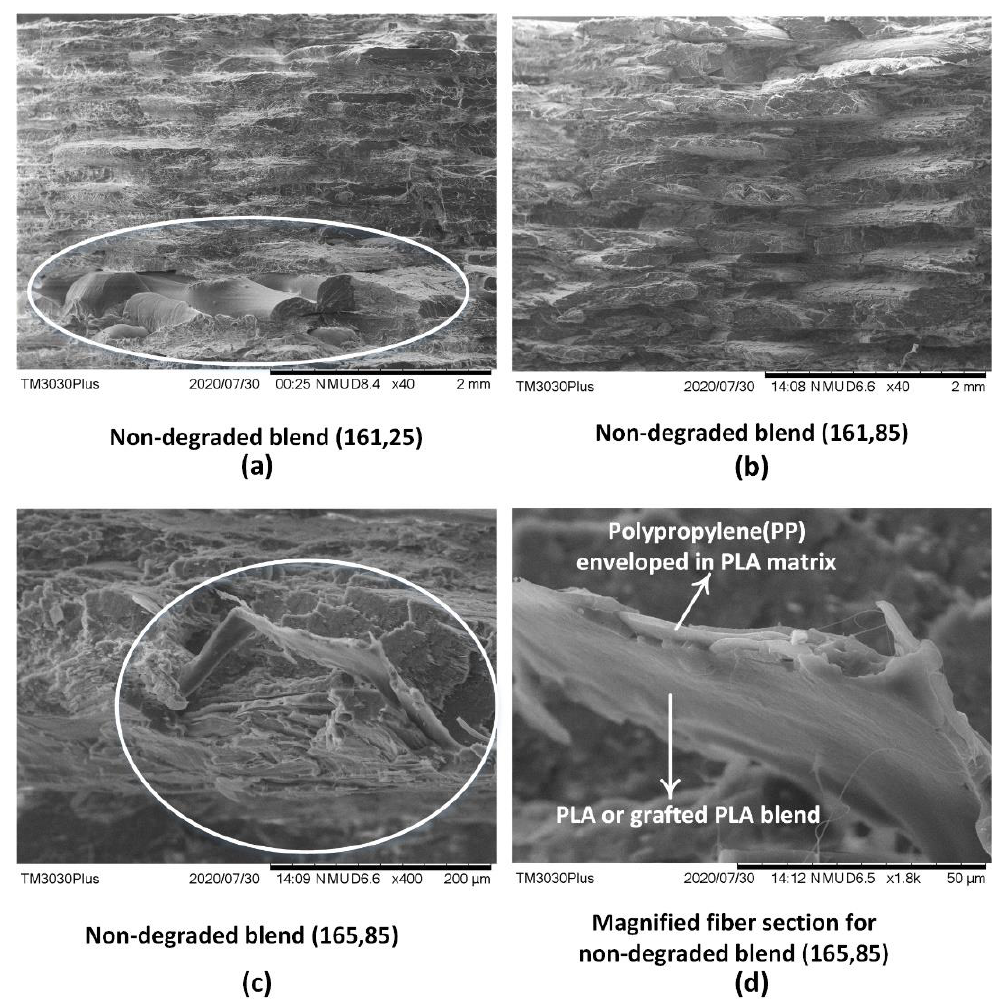
Figure 8. SEM analysis for: ( a )non-degradable blend (161 ◦ C, 25 ◦ C), ( b )non-degradable blend (161 ◦ C, 85 ◦ C) at 40X, ( c ) non-degradable blend at (161 ◦ C, 85 ◦ C) at 400X, and ( d ) magnified image of PP fiber (161 ◦ C, 85 ◦ C) at 1800X.